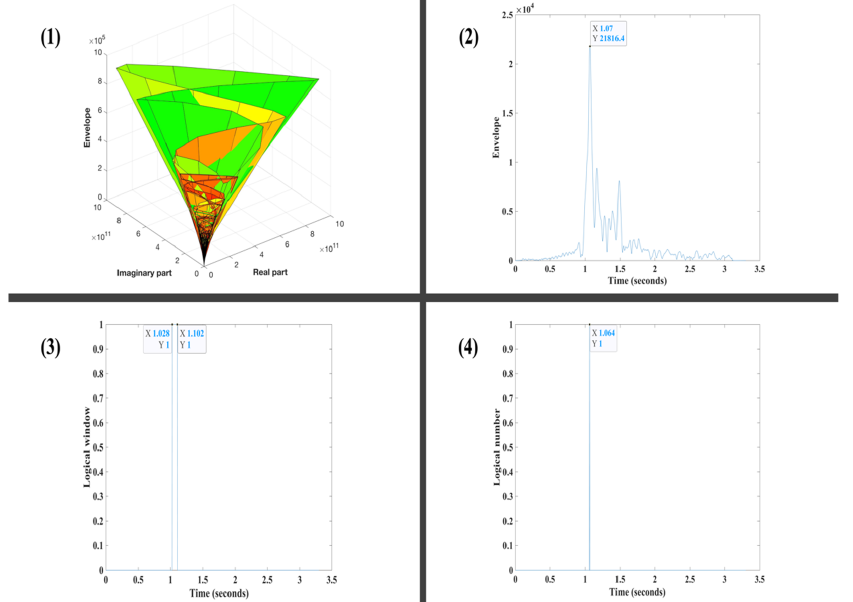
Figure 2. Steps 1–4 of the HEEH method applied to a real Vibroseis trace: ( 1 ) The Hilbert transform of the trace in Figure 1 results in a complex seismic trace. ( 2 ) The envelope step amplifies the